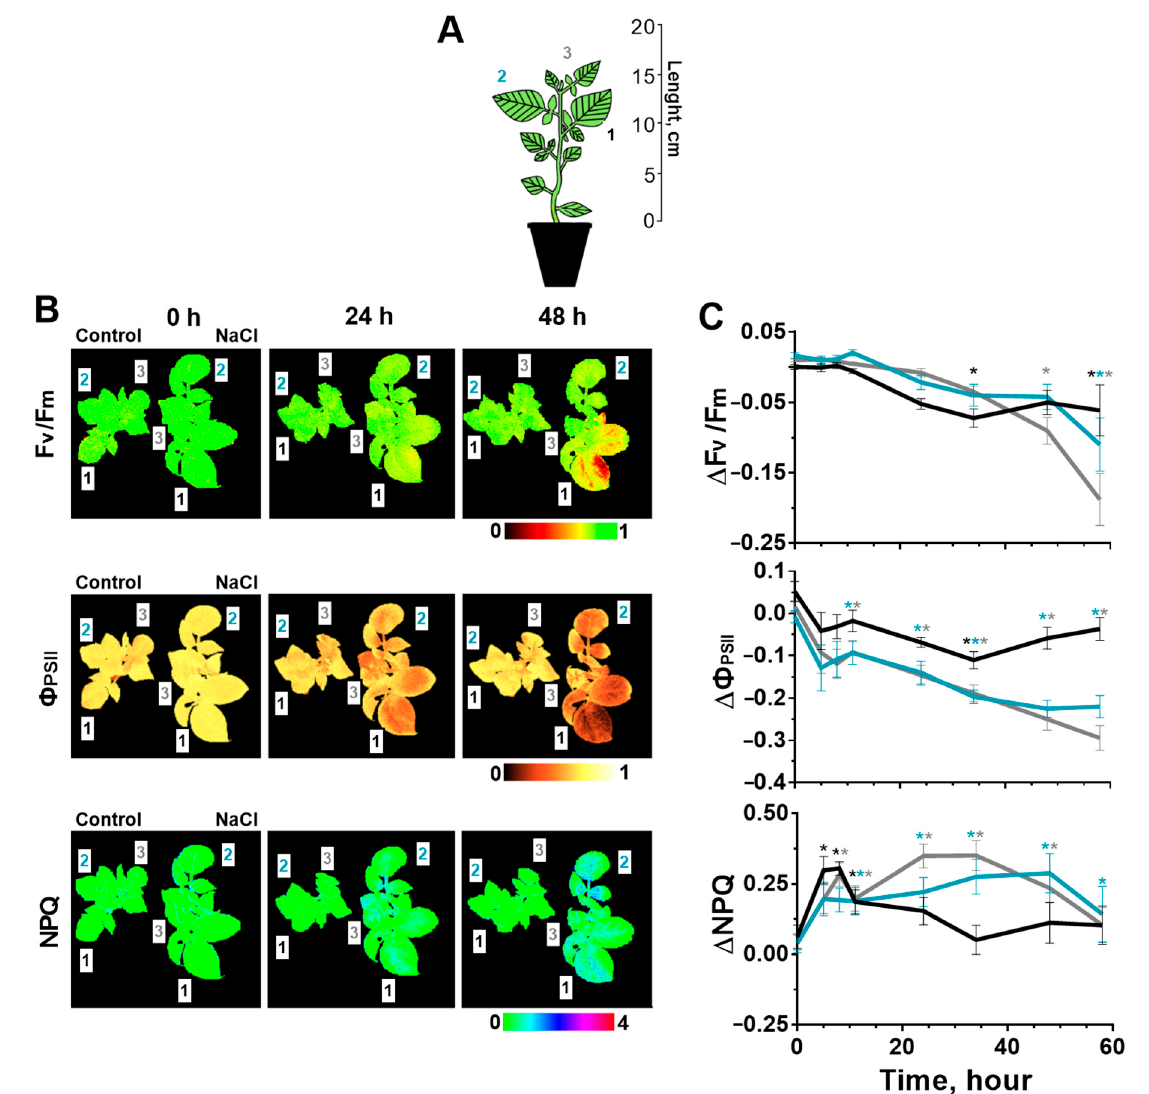
Figure 2. Effect of salt stress on photosynthesis in three potato leaves located at different height on the shoot (1, 2, 3) ( A ). Changes of F v /F m , φ PSII and NPQ are demonstrated as whole-plant imaging in the pseudo-color scale in control (Control) and salt–treated (NaCl) plants at three time points (0, 24 and 48 h) ( B ), as well as presented in the form of changes relative to control values (1—black, 2—blue, 3—gray) ( C ). The data are presented as mean ± SEM (n = 9), * p < 0.05 control versus salt treatment. Parameters of the photosystem II activity changed in tobacco leaves under